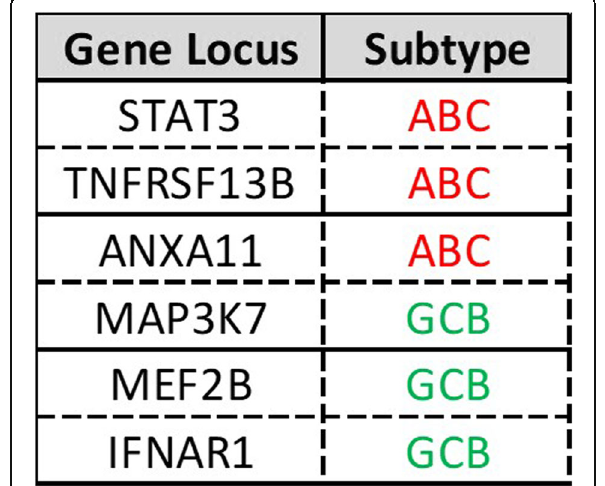
Fig. 2 The EpiSwitch DLBCL-CCS classifier. The DLBCL-CCS is made up of measurable changes in the genomic architecture at six genomic loci. These “ gene loops ” are either absent or present in different DLBCL subtypes, for example in the ABC subtype loops in STAT3, TNFRSF13N and ANXA11 are present while loops in MAP3K7, MEF2B and IFNAR1 are absent. The converse pattern is observed in GBC